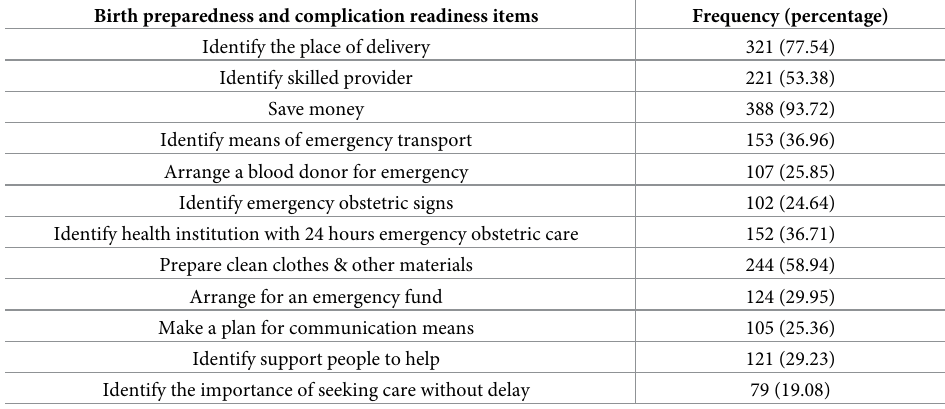
Table 4. Arrangement items for BP/CR plan among pregnant women attending antenatal care service at North Shewa zone public hospitals, Oromia region, central Ethiopia, 2021 (n =